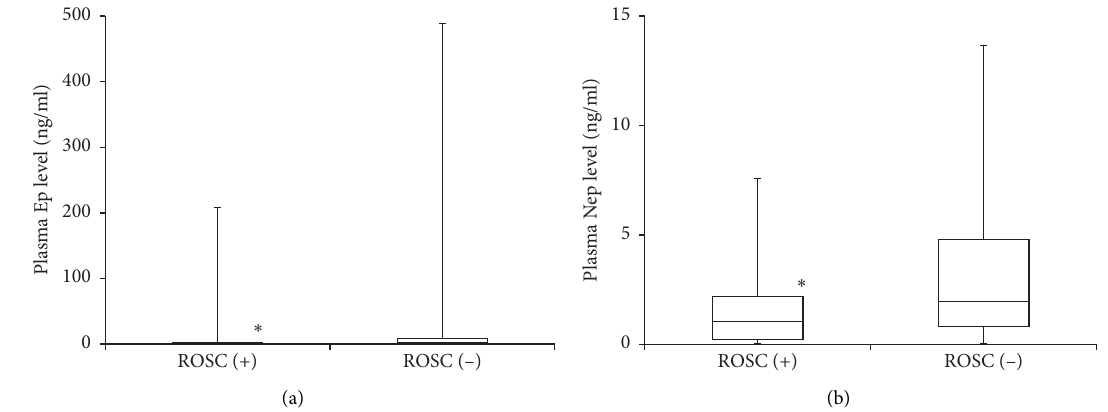
Figure 2: Comparisons of Ep and Nep levels in the plasma. (a) Comparison of Ep levels in the plasma. The normal levels of Ep in the plasma are ≤ 0.10ng/ml ( ∗ P < 0 . 05).(b) Comparison of Nep levels in the plasma. The normal range of Nep levels in the plasma is